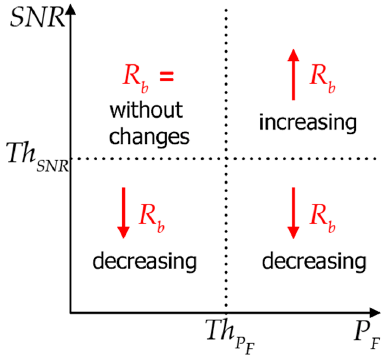
Figure 1. The principle of operation of the LA algorithm.